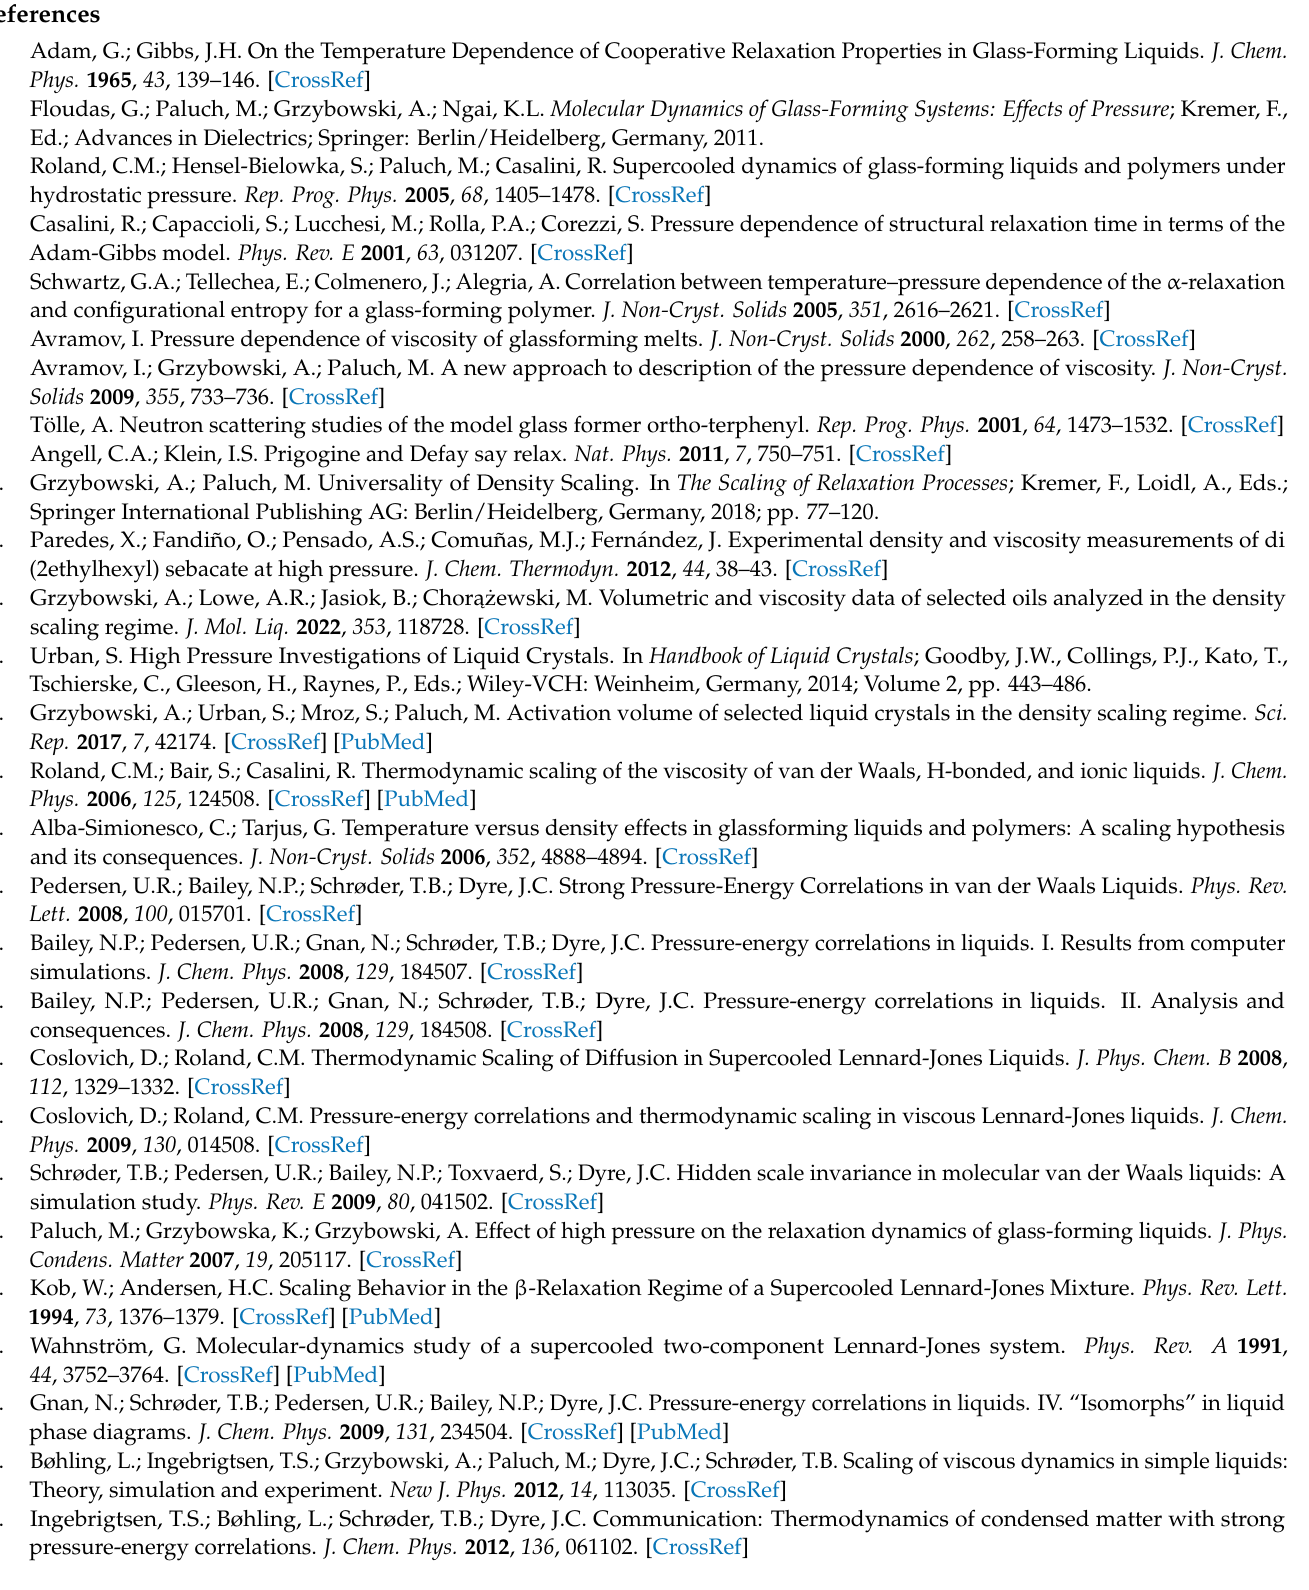
represent the fits to the EoS given by Equation (A1) with the value of its parameters collected in Table A1. In the separate panels, there are the cases shown for the different anisotropy aspect